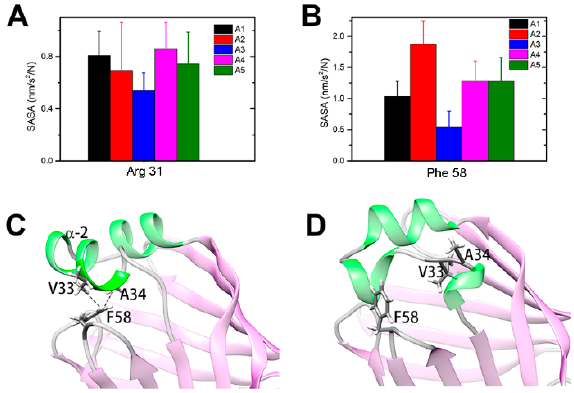
Figure 5. The solvent-accessible surface area (SASA) and contact analysis of apo-HFABP: ( A ) SASA of Arg31 in different intermediates of apo-HFABP; ( B ) SASA of Phe58 in different intermediate states; ( C ) The hydrophobic interactions between residue F58 and V33/A34 in the “closed” state A3; ( D ) The interactions between F58 and V33/A34 were broken in the open intermediate states. The SASAs were calculated by the gmx-sasa module implemented in Gromacs.